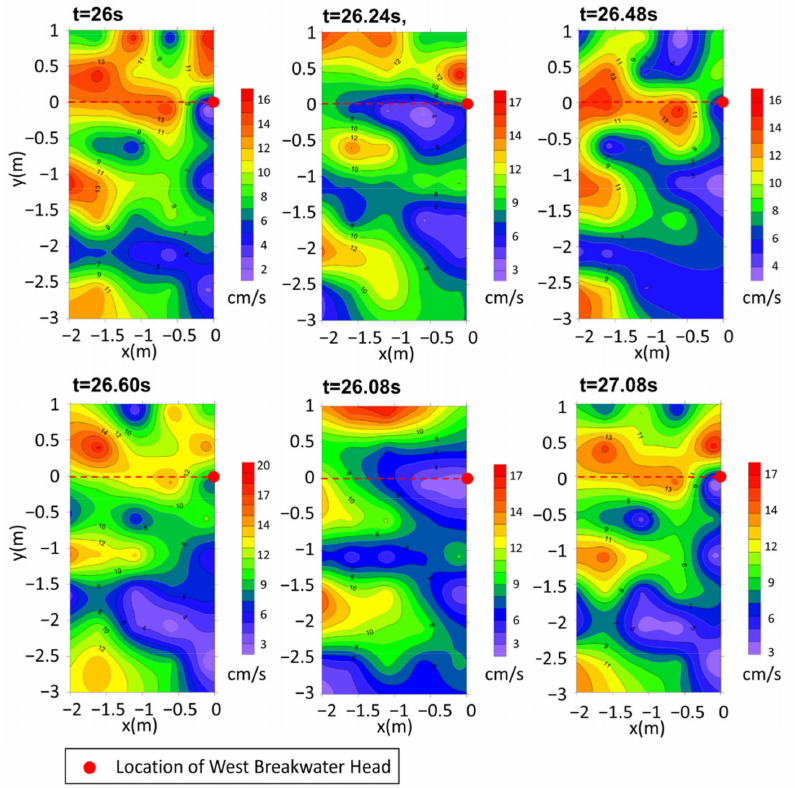
Figure 25. U at west side of West Breakwater under the action of typhoon waves (z = − 15